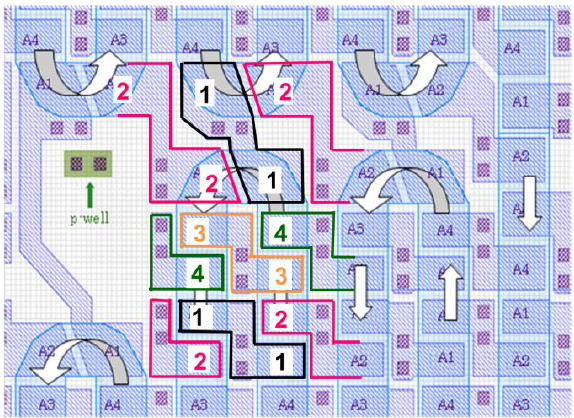
Figure 6. A zoom of the CCD/CMOS ISAS in Figure 5. Z-shaped electrodes enable a folded CCD channel. Those electrodes facing each other across the channel stop automatically change the transfer directions as well